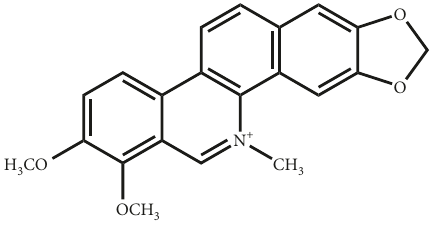
Figure 1: The molecular structure of